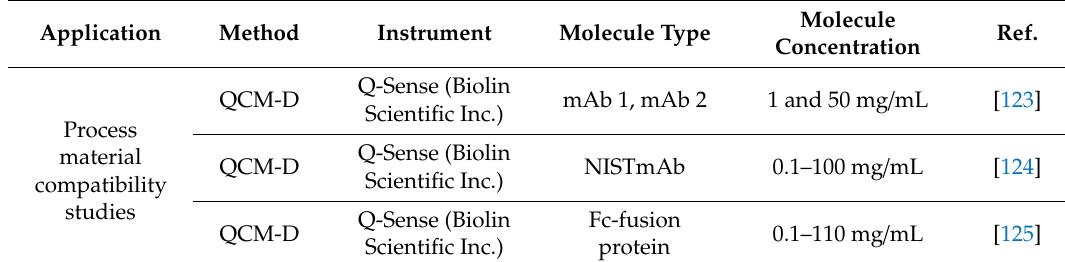
Selection of the QCM system in drug product manufacturing process development-related